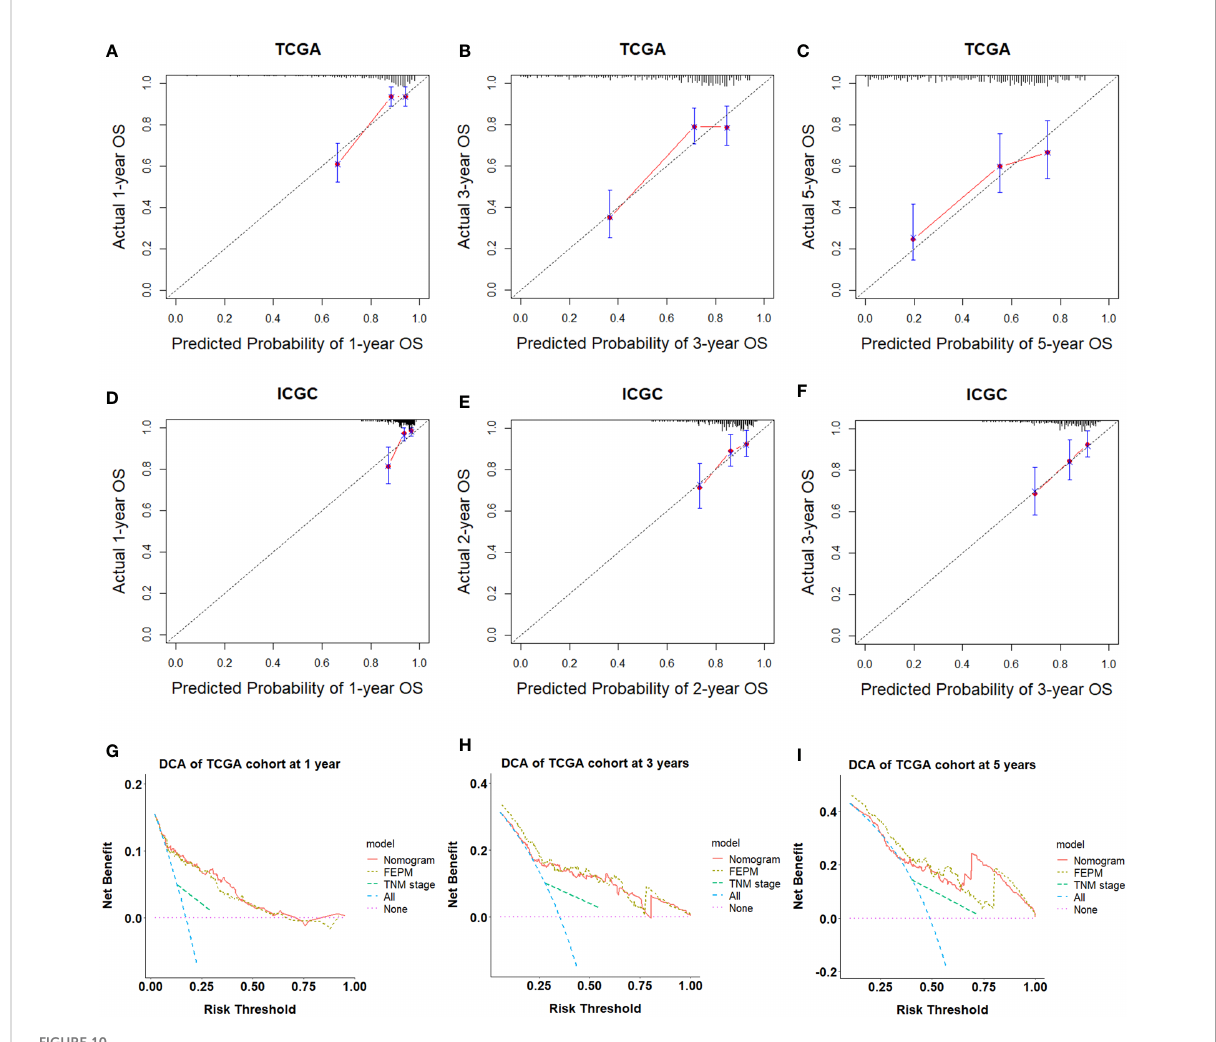
FIGURE 10 (A-F) Calibration curves showed the nomogram had great consistency. (G-I) Decision curve analysis showed that the nomogram could provide clinical bene fi ts within a wide range of